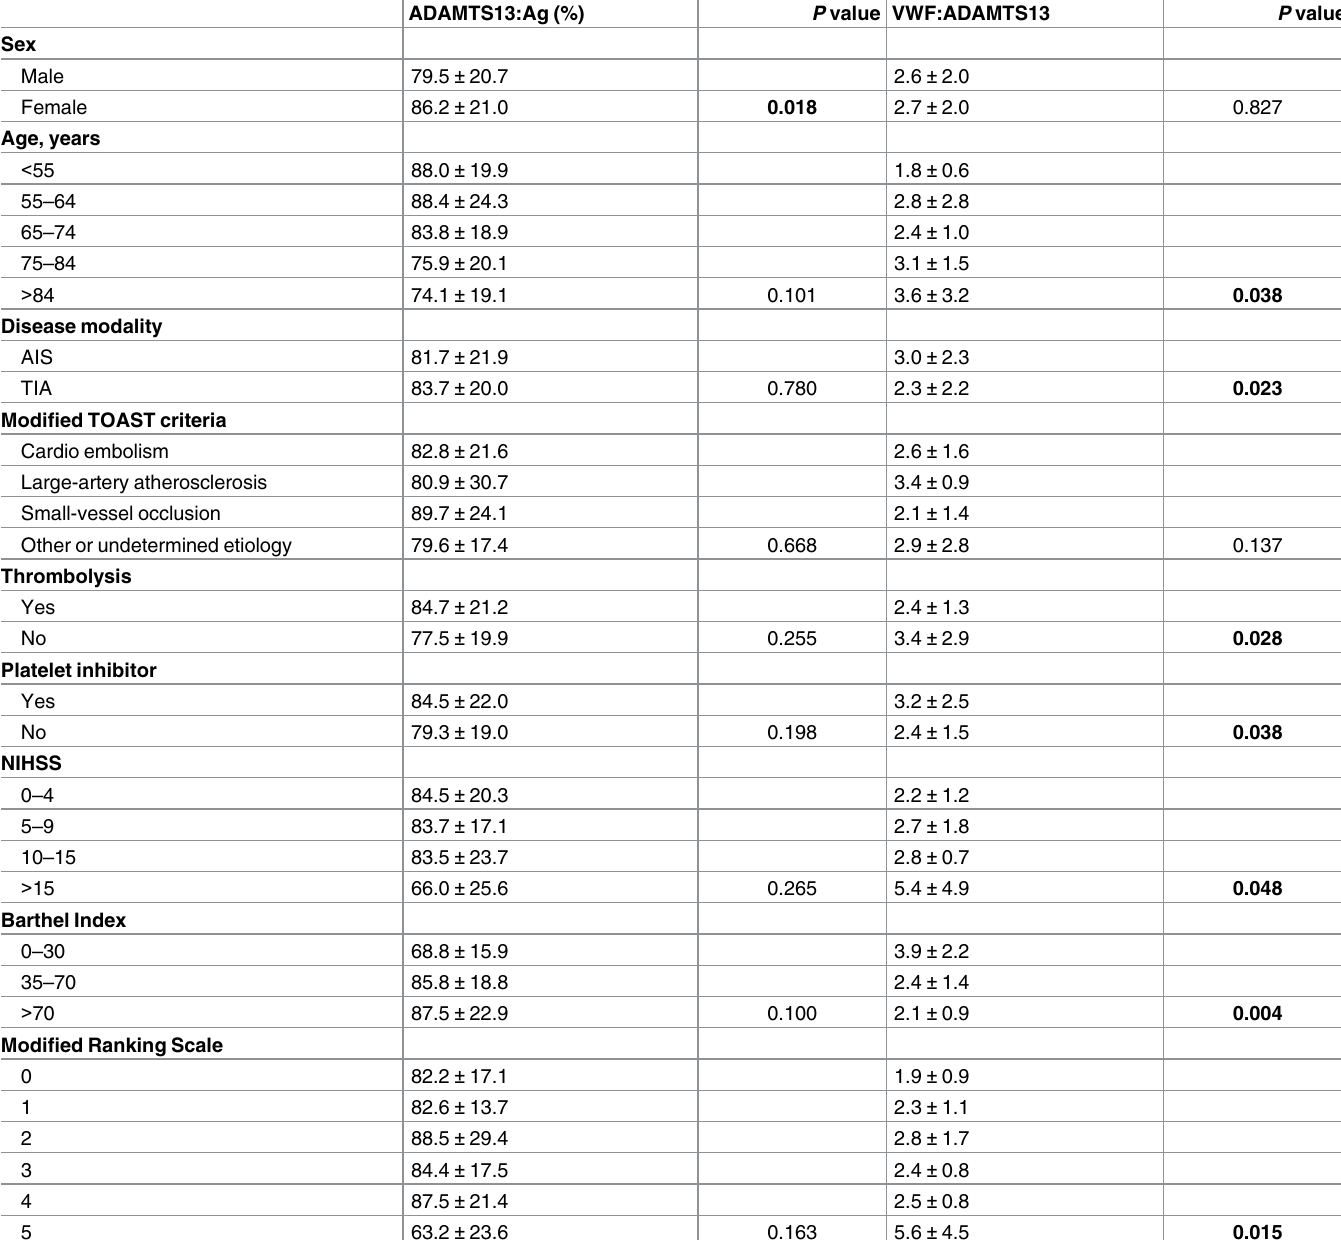
Table 2. Univariate analysis of ADAMTS13 levels and the VWF:ADAMTS13 ratio with demographic and clinical parameters. Data are represented as mean ± standarddeviation(SD). Data were analyzedby an independent samples Mann-Whitney U test or Kruskal-Wallis test, where applicable.(AIS: acute ischemic stroke; TIA: transient ischemicattack; NIHSS: NationalInstitutes of Health stroke scale). ADAMTS13:Ag